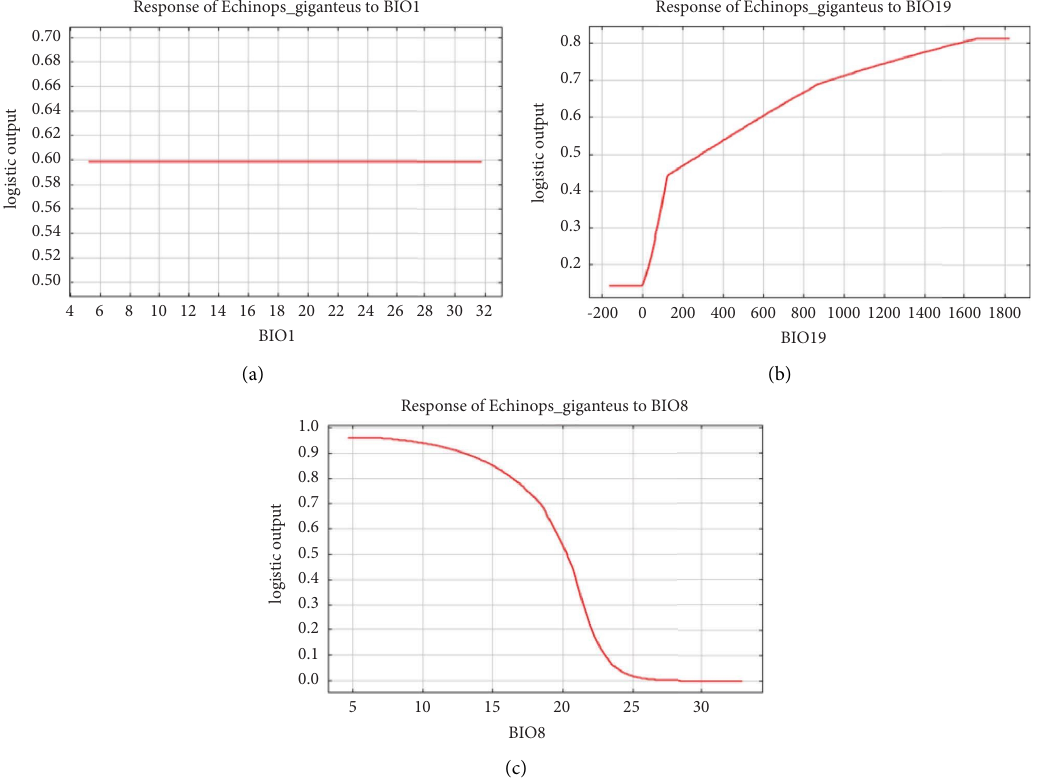
Figure 5: MaxEnt model logistic function curves of the response of key climate factors. (a) Mean annual temperature (Bio1), (b) precipitation of the coldest quarter (Bio19), and (c) mean temperature of the wettest quarter (Bio8).